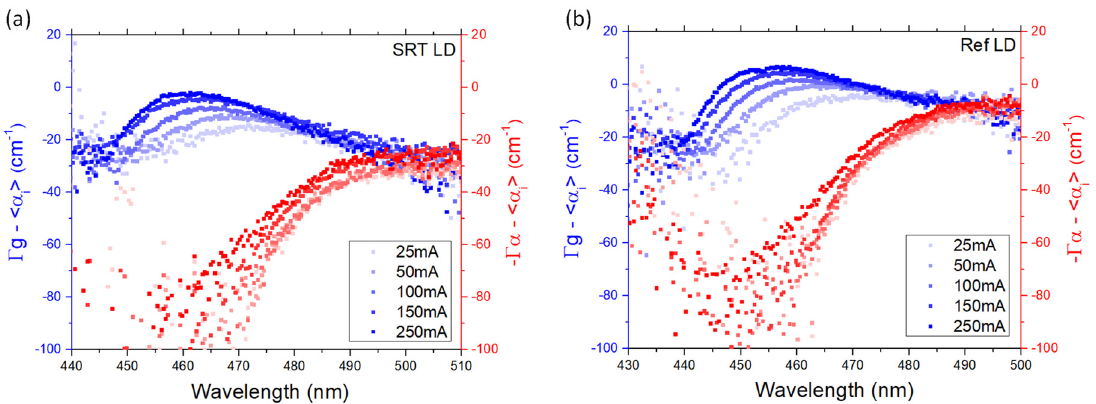
Figure 4. Results of the segmented contact measurement of ( a ) SRT LDs, ( b ) reference LDs. A three − times − higher internal loss is observed in the SRT lasers.